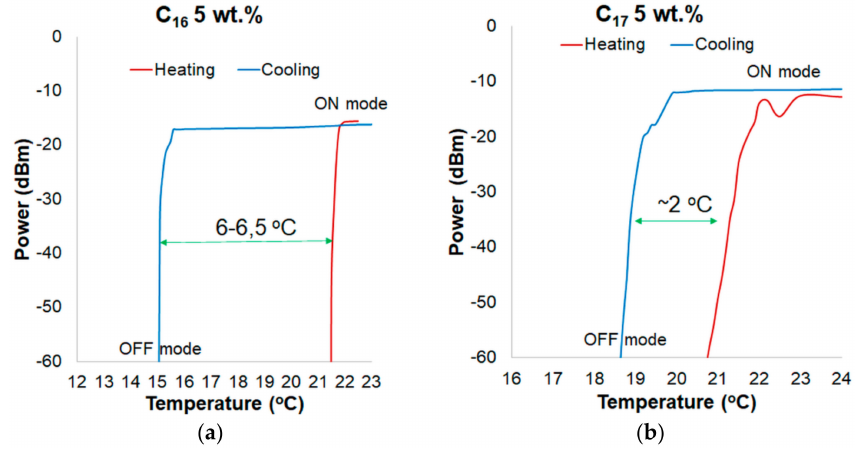
Figure 10. Hysteresis of power changing for a wavelength of 810 nm for: ( a ) pure C 16 and ( b ) pure C 17 .